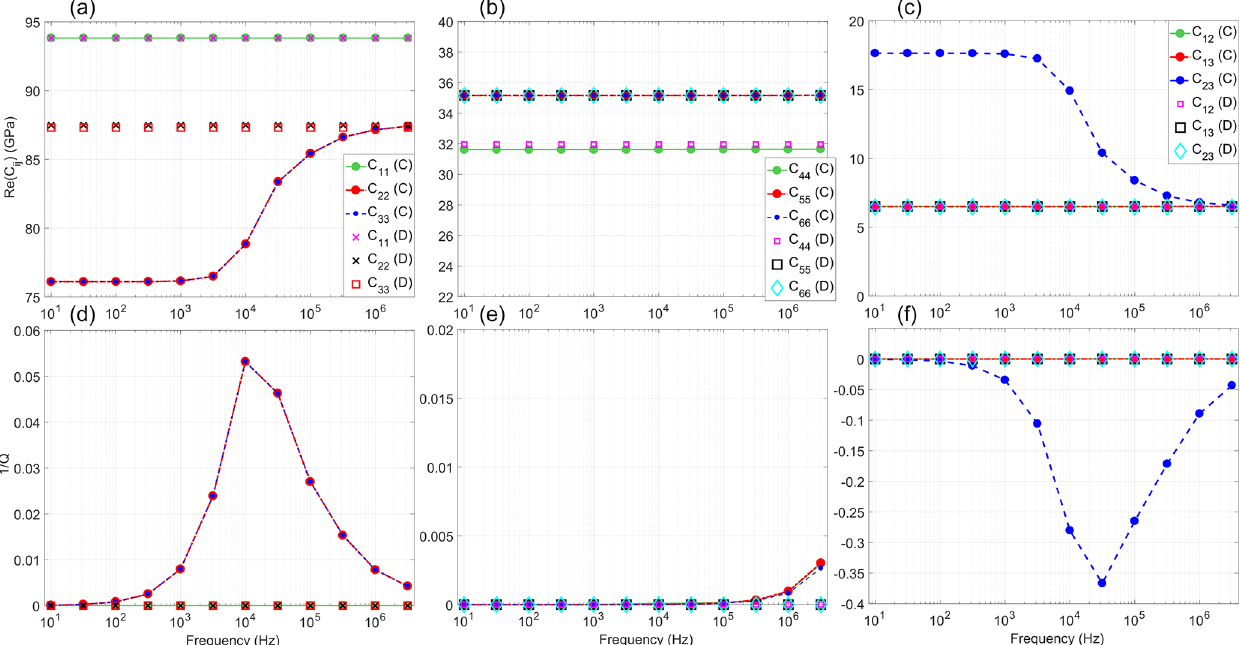
Figure 4. Numerical results for the connected (C) and disconnected (D) crack models: real part of the c ij components versus frequency (a– c) , dimensionless inverse quality factor of the c ij components versus frequency (d–f) . Each symbol corresponds to the test result of one numerical simulation and lines correspond to linear interpolation between discrete numerical